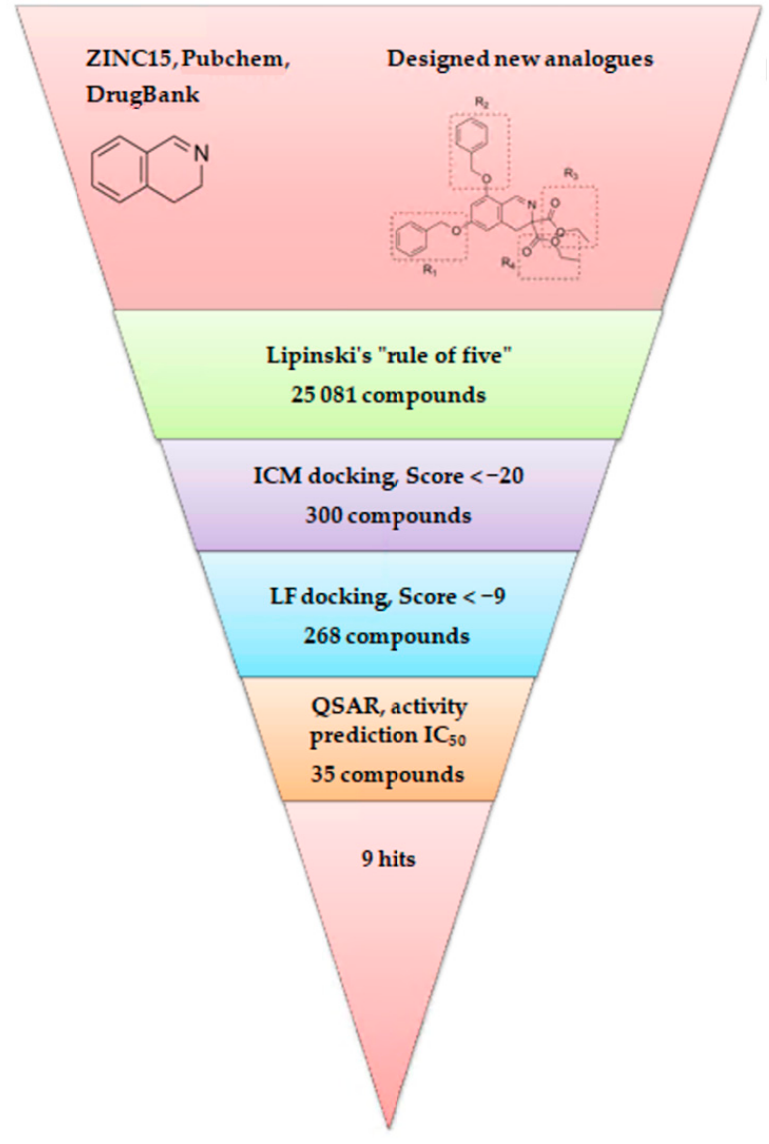
Figure 6. Schematic representation of the used